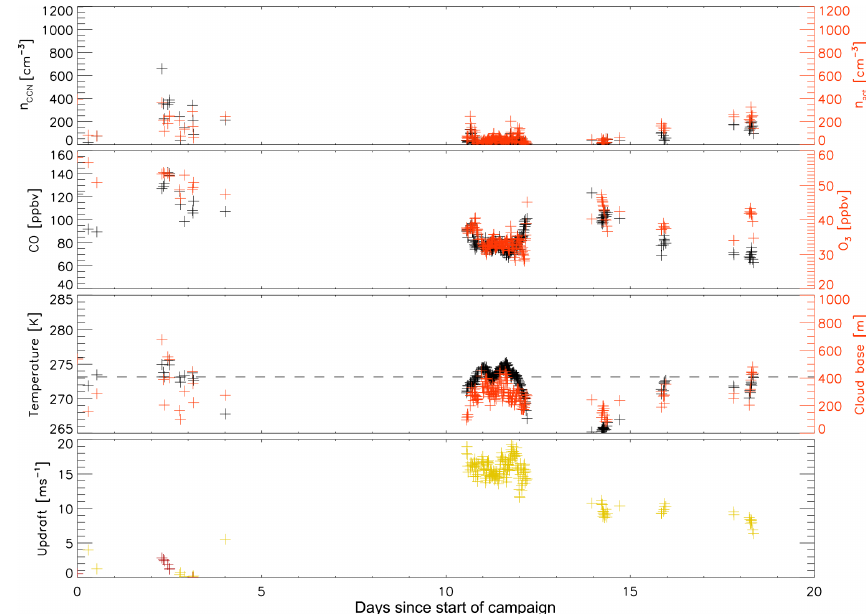
Figure 3. As for Fig. 1 but for CLACE2004. Note that the axis ranges differ from those in Fig.